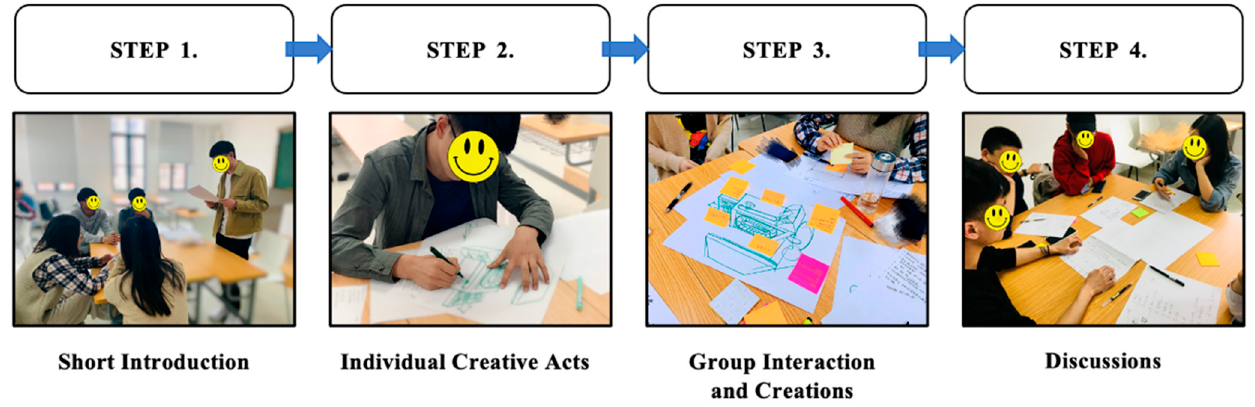
Figure 1. Co-design workshop procedures .